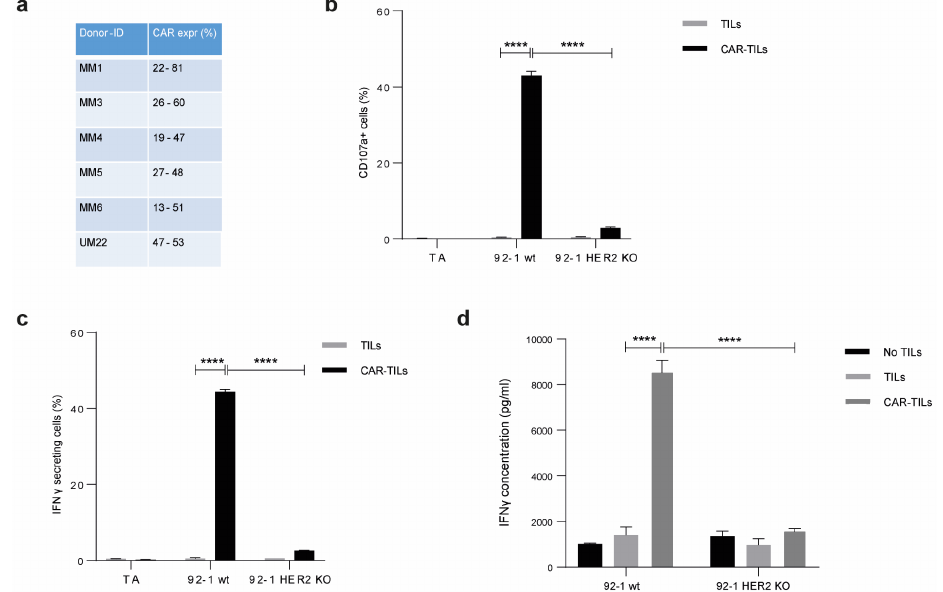
Figure 1. TILs can be activated by equipping them with a CAR construct. mRNA encoding anti-HER2 CAR was electroporated into TILs from five cutaneous melanomas (MM1, MM3, MM4, MM5, and MM6) and one uveal melanoma (UM22) to produce CAR-TILs. CAR expression was detected by HER2-biotin binding at 5–16 h post-transfection ( a ). MM1 TILs and CAR-TILs were co-cultured with the parental or HER2 KO 92-1 uveal melanoma cell line for 4–6 h, followed by flow cytometry to measure degranulation (CD107a expression) ( b ) or IFN- γ -secreting cells ( c ). TILs and CAR-TILs not co-cultured with 92-1 cells (TILs alone; TA) were used as controls in ( b , c ). Alternatively, cells were co-cultured for 48 h, and the supernatant was collected for analysis of secreted IFN- γ by ELISA ( d ). 92-1 cells not co-cultured with TILs (no TILs) were used as a control. Data are presented as mean ± standard deviation (SD) of duplicates. The experiments were performed twice, and representative results are shown. p values are represented as **** p <